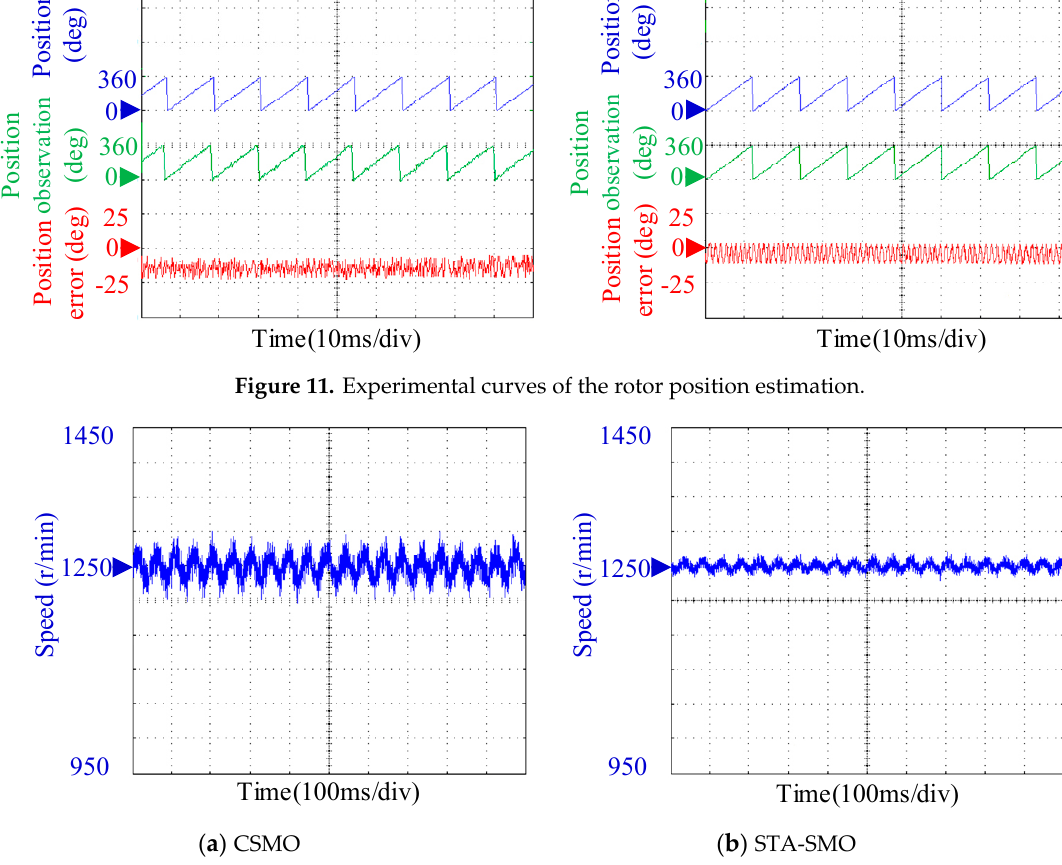
Figure 12. Experimental curves of the speed estimation.